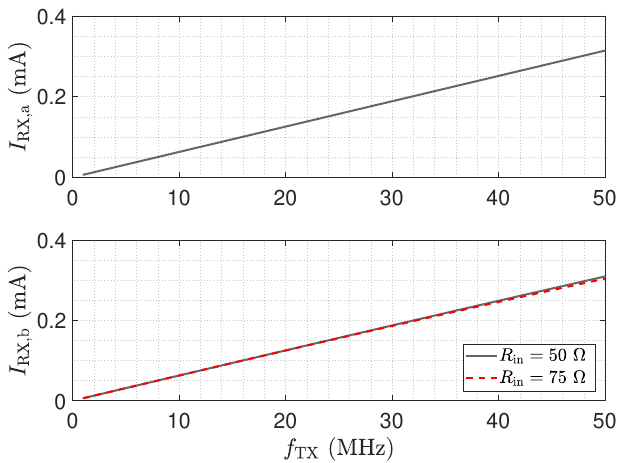
Figure 5. Receive current frequency responses for the low-Z circuit (upper plot) and matched input stage (lower plot) depicted in Figure 4a,b, respectively. An excitation voltage V TX of 1V is applied, C X = 1pF, C s0 = C s1 = 10pF. The maximum low-Z received current at a frequency of 50MHz